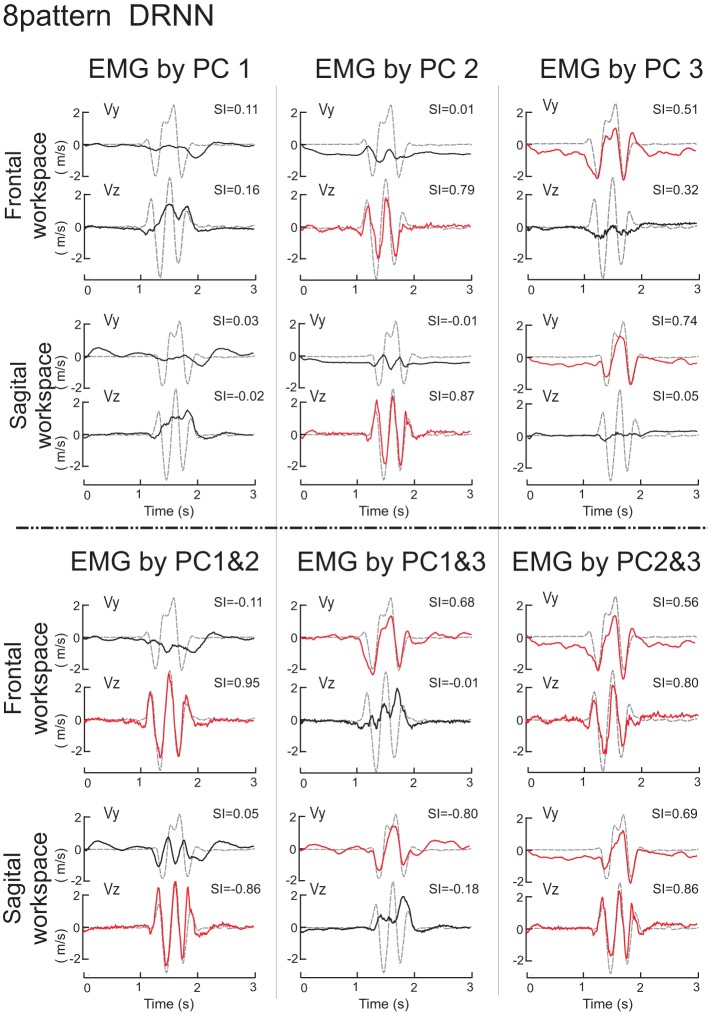
Simulations with the 8-pattern DRNN trained on move- ments from both planes. In this figure are illustrated the simulations for EMG signals reconstructed by means of PC1, PC2, PC3 (top part of the figure) and PC1&2, PC1&3, and PC2&3 (bottom part) for the same figure-eight movement (initiated down and to the right) realized in the frontal (first row) and sagittal (second row) workspaces. Real curves are represented by gray dashed traces and simulated curves by black and red traces. Traces were drawn in red when the SIs exceeded a threshold arbitrarily set to 0.5. SIs are indicated in the upper right corner of each graph.